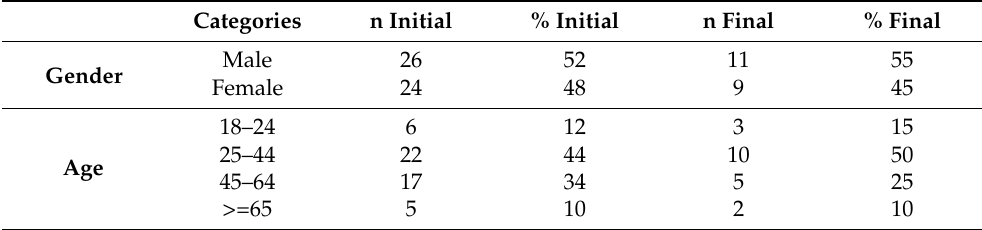
Table 2. Demographic distribution of subjects by gender and